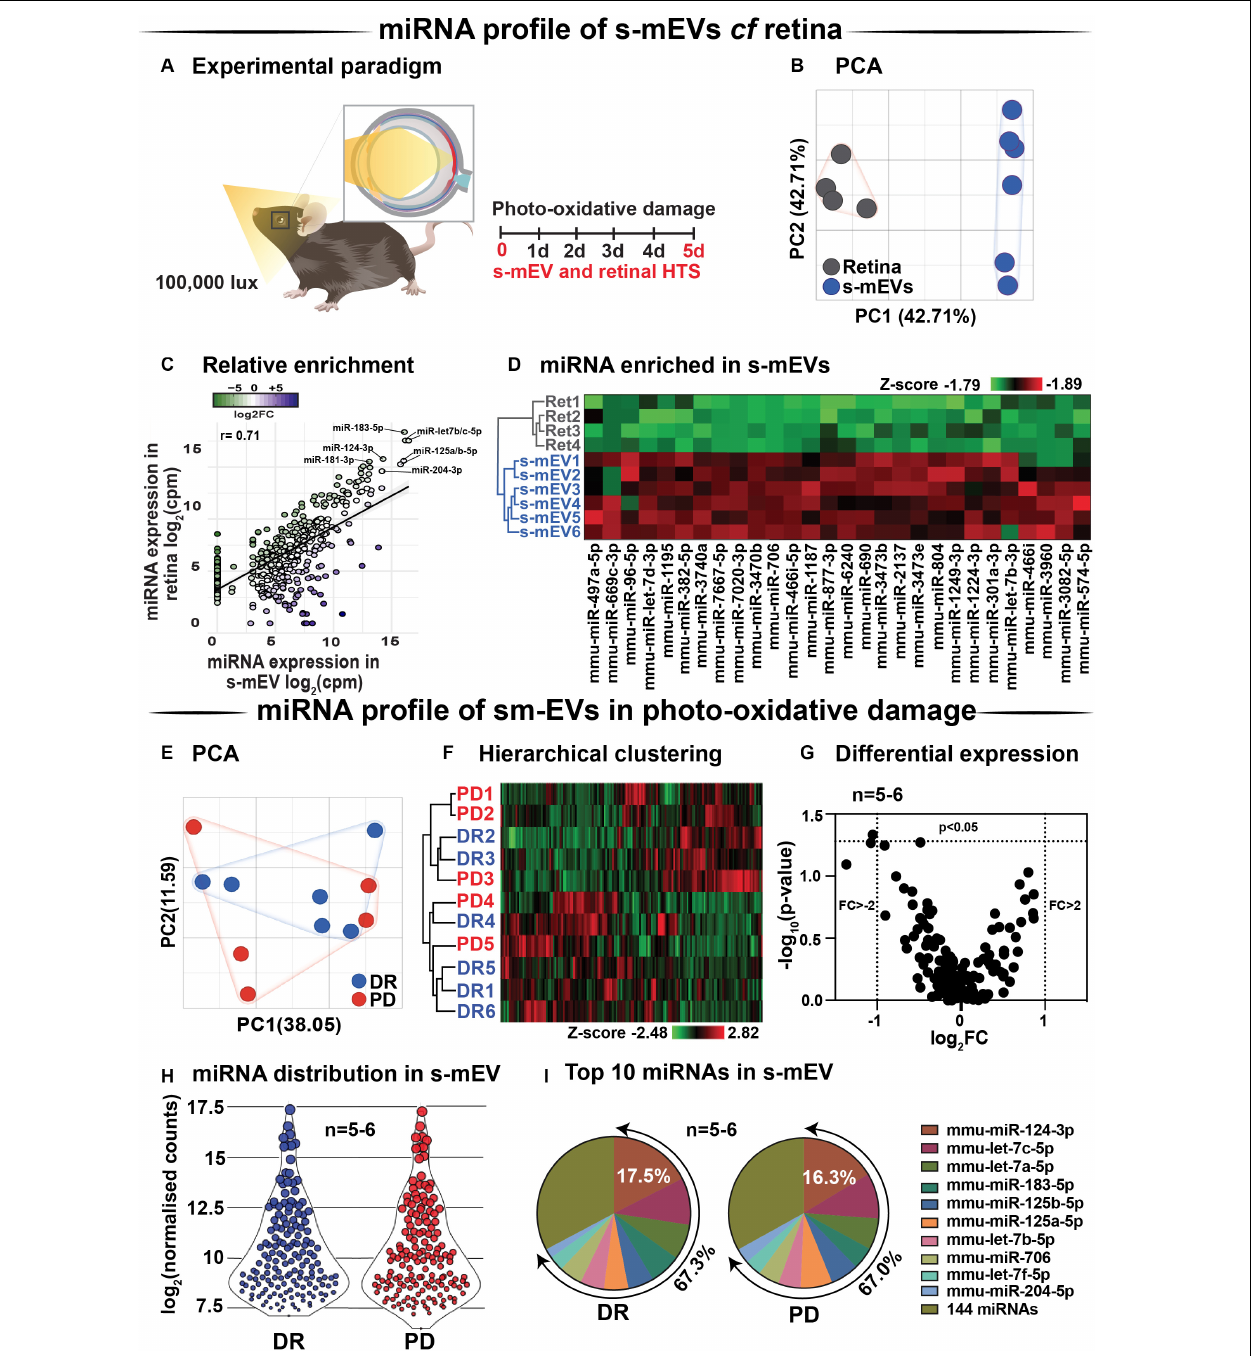
FIGURE 7 | s-mEV miRNA profiling and enrichment analysis. (A) Experimental paradigm with red retinal labeling indicating lesion site. (B) Principal component analysis (PCA) of retinal miRNA and s-mEVs miRNA showed clear clustering suggesting that each group possesses uniquely enriched miRNA. (C) A positive correlation was observed ( r = 0.71, p < 0.0001) between miRNA counts in the dim-reared retina and s-mEVs with miR-124-3p, miR-181-3p, miR-204-3p, miR-125a/b-5p, and miR-let7a/b-5p being abundant in both. (D) Hierarchical clustering of miRNA showed significant enrichment of miRNA in s-mEVs compared to the dim-reared retina (FC > 2, FDR < 0.05). (E) PCA and (F) hierarchical clustering analysis show no grouping or miRNA between DR and PD samples and identified no outliers. (G) Volcano plot indicating that no differential analysis was observed in s-mEV from DR and 5D PD retinas ( P > 0.05, n = 5-6). (H) Violin plots showing the distribution of miRNA transcripts in s-mEV from DR and 5D PD retinas ( n = 5–6). Each data point represents the log 2 transformed average number of counts for each miRNA retained after removing miRNAs with low expression and the size of each point is proportional to the average expression value of each miRNA. s-mEV from both DR and 5 days PD retinas contain similar amounts of miRNA transcripts with low, medium and high expression. (I) The top 10 most abundant miRNA were conserved in retinal s-mEV from DR and 5 days PD retinas and accounted for approximately 67% of the total counts.